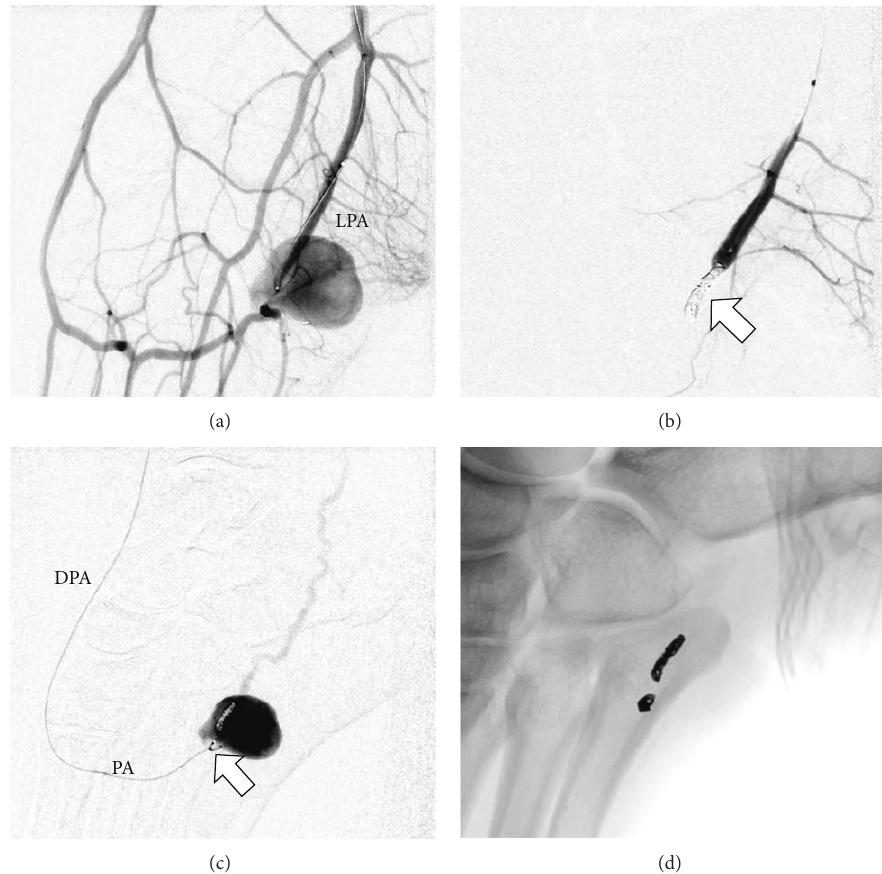
Figure 3: Frontdoor ((a) and (b)) and backdoor ((c) and (d)) coil embolization of the pseudoaneurysm with microcoils (white arrows). Angiography was performed through the 4-Fr catheter in the popliteal artery (a), respectively, the microcatheter in the lateral plantar artery (b) and plantar arch (c). The left lateral plantar artery was catheterized via the posterior tibial artery and the deep plantar arch via the dorsalis pedis artery (approached through the anterior tibial artery). DPA = dorsalis pedis artery. PA = plantar arch. LPA = lateral plantar artery.